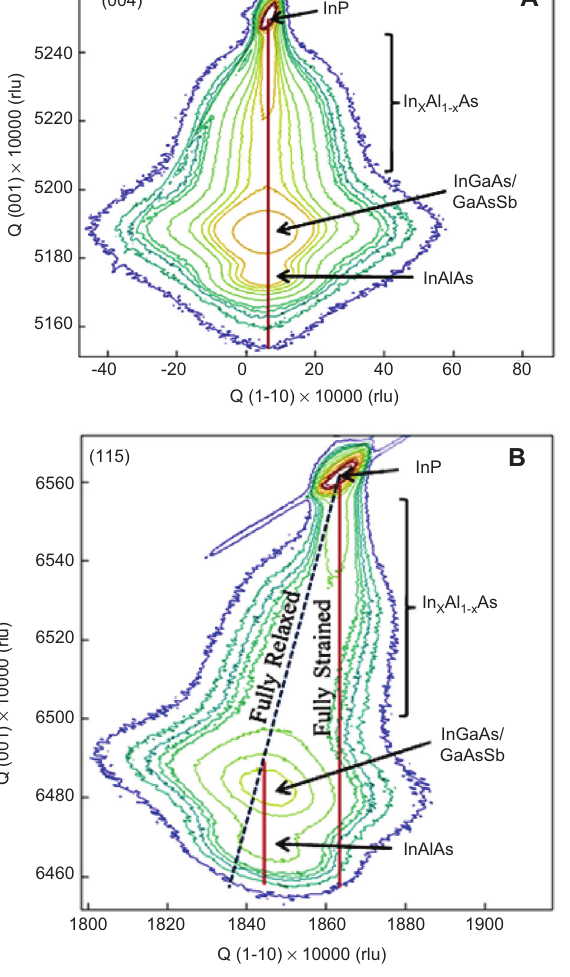
Figure 19 (A) Symmetric (004) and (B) asymmetric (115) RSMs of the GaAs-like interface TFET with a layer structure as shown in Figure 17C using an incident X-ray beam along the [1ī0]